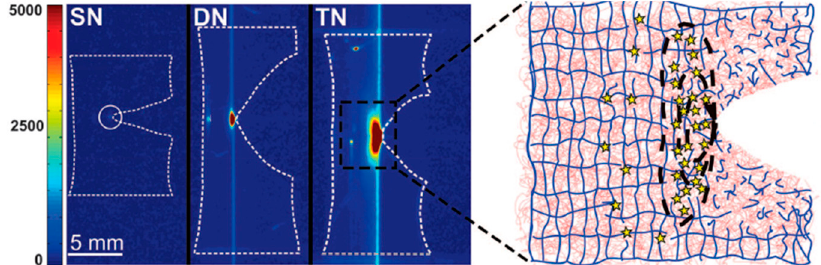
Figure 5. Mapping of location where bonds break during crack propagation. ( Left ) Intensity-colored images of propagating cracks on notched samples containing a chemiluminescence cross-linker in the first network, showing light emission due to breaking of bonds in the single-network (SN), double-network (DN), and triple-network (TN) samples. ( Right ) Schematic of the sacrificial bond-breaking mechanism in front of the crack tip for the DN and TN; the first network is represented in blue, and the second and third networks are in red. Adapted and reprinted with permission from [17].